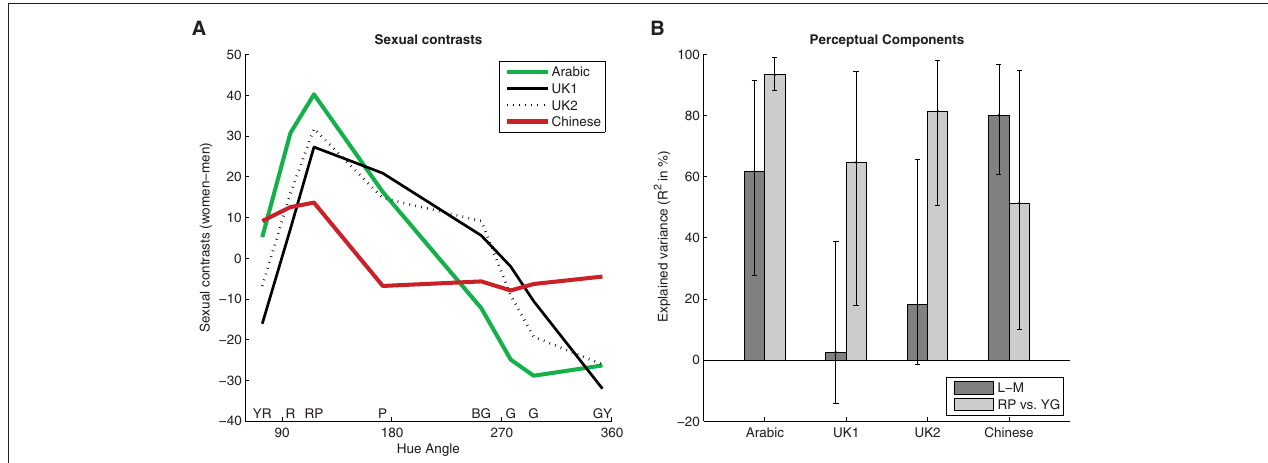
FIGURE 1 | Sexual contrasts in Al-Rasheed’s (2015) and Hurlbert and Ling’s (2007) study. (A) Sexual contrasts (average preferences of women—average preferences of men) along the y-axis as a function of CIELUV hue angle in degree for Arabic (green curve; 36 women and 32 men), and English observers (solid black curve; 31 women and 17 men) in Al-Rasheed’s (2015) study, and for English (dotted black curve; 92 women and 79 men) and Chinese (red curve; 18 women and 19 men) observers in Hurlbert and Ling’s (2007) study. (B) Variance of sexual contrasts across colors explained by the biological component model (L-M). Error bars show 90% confidence interval (i.e., 95% for one-tailed tests, as here) based on boot-strapping of the correlation coefficient r (Pernet et al.,